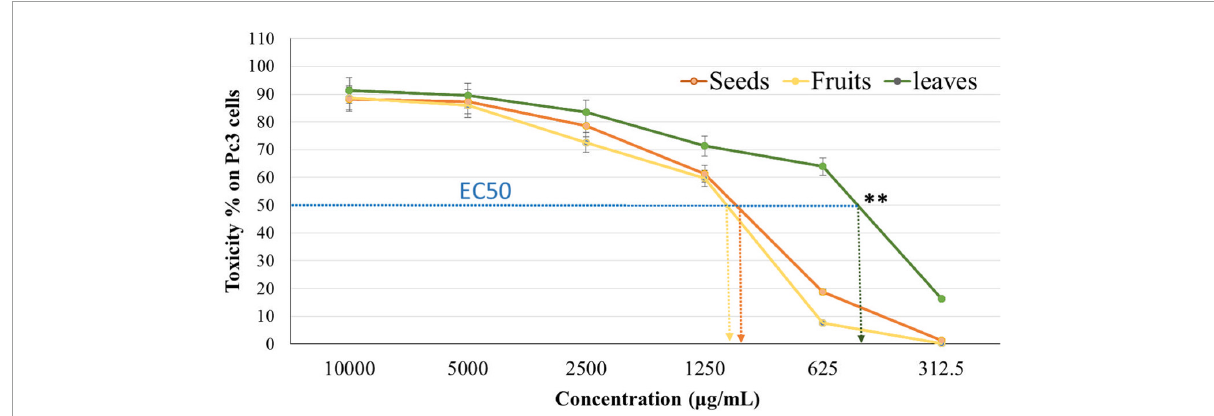
FIGURE3 Cytotoxic effect of leaf, seed, and fruit extract on prostate cancer cells (Pc3). ∗∗ P -value was considered highly significant ( P < 0.01).